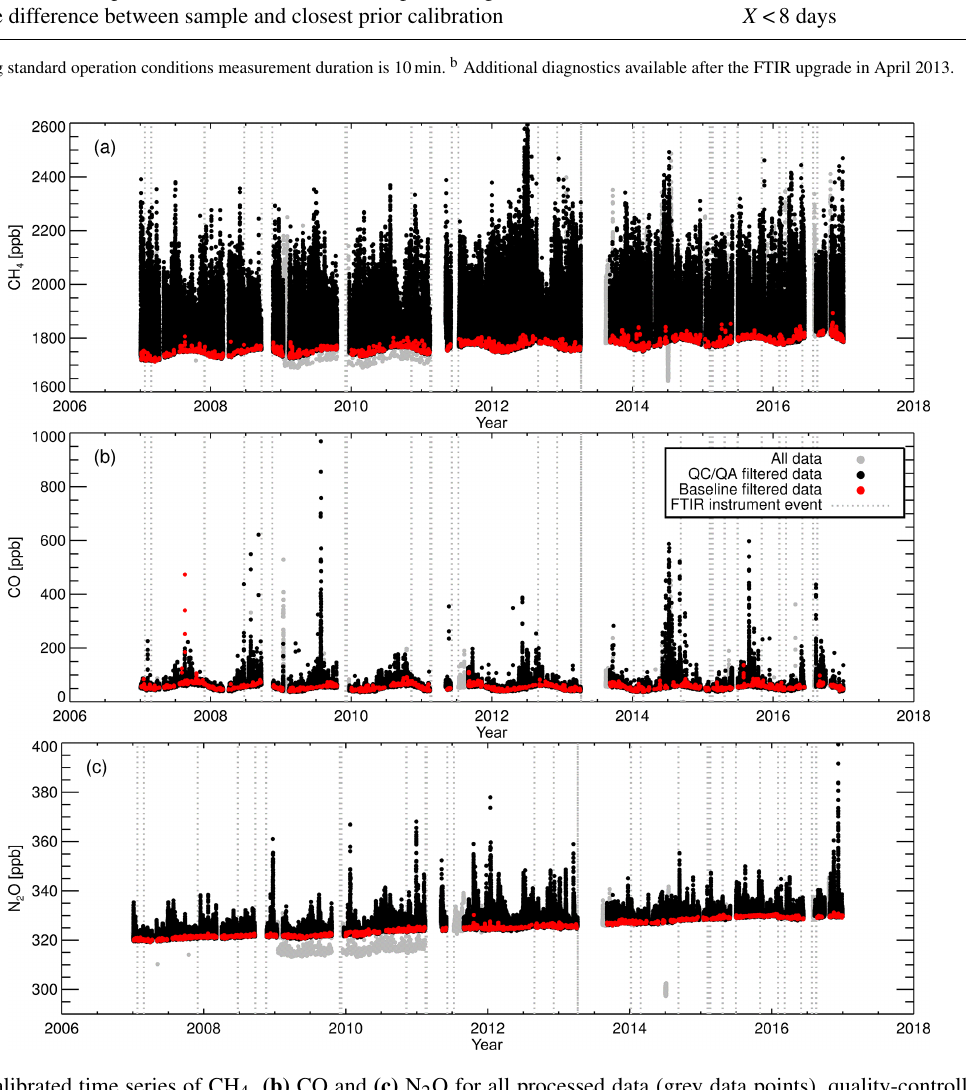
Figure 12. (a) Calibrated time series of CH 4 , (b) CO and (c) N 2 O for all processed data (grey data points), quality-controlled data (black data points) and quality-controlled data during baseline conditions (red data